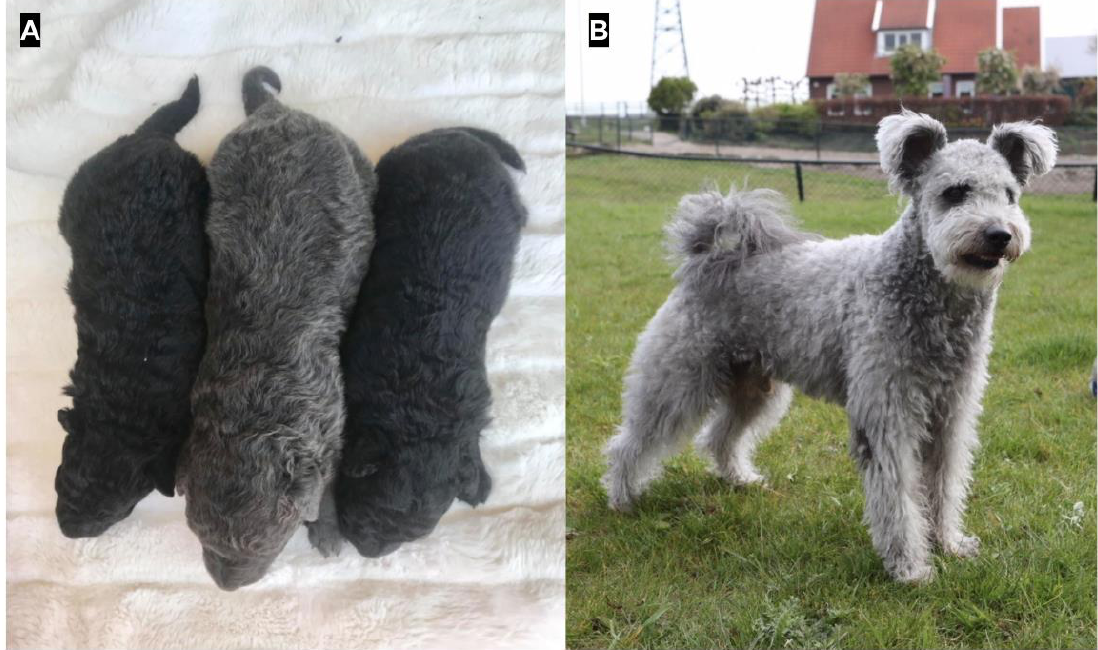
Figure 1. Examples of dogs with a dilute phenotype. A , a dilute Hungarian mudi puppy flanked by its black siblings; B , a dilute Hungarian pumi.